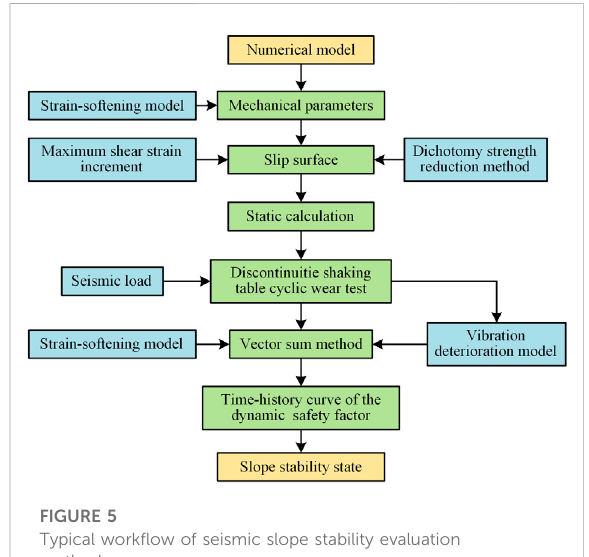
FIGURE 5 Typical work fl ow of seismic slope stability evaluation method.